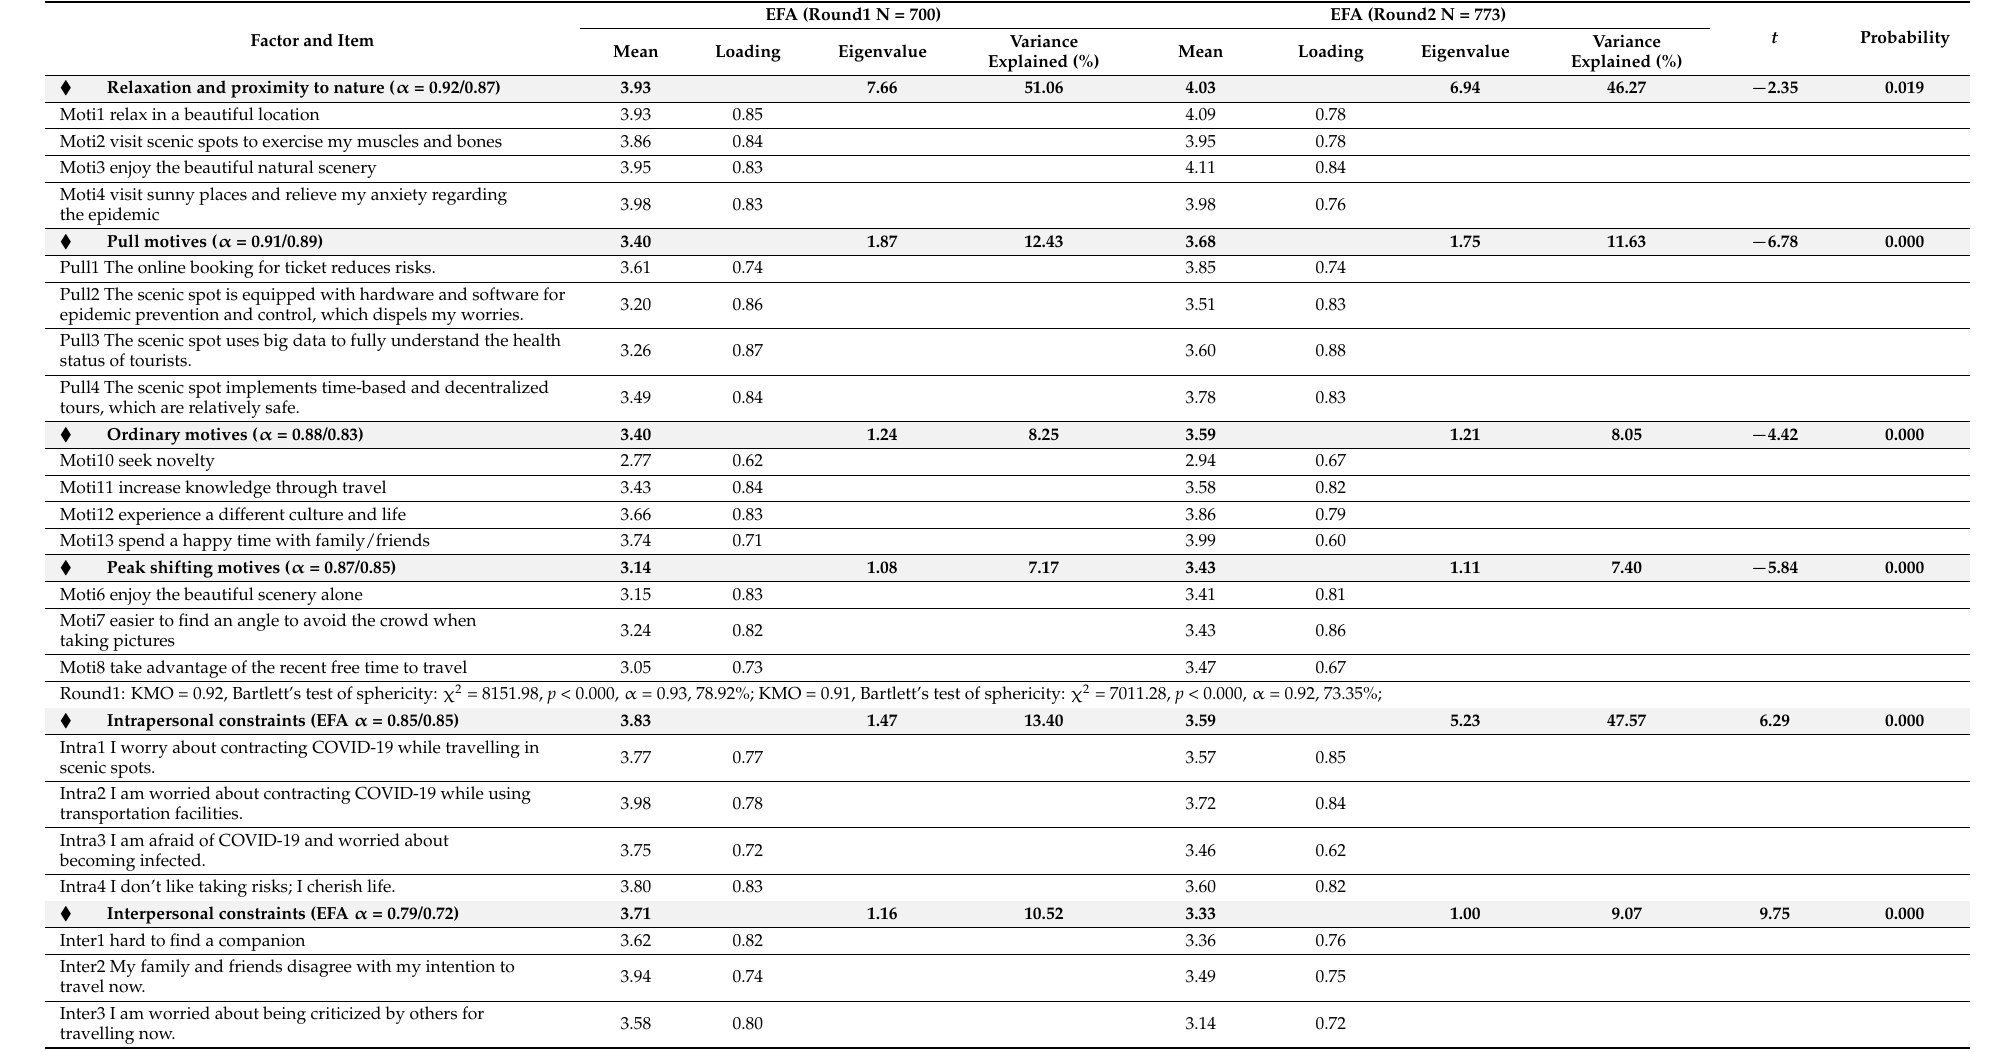
Table 1. Factor analyses on travel motivation and constraints items and the result of t test. Factor and